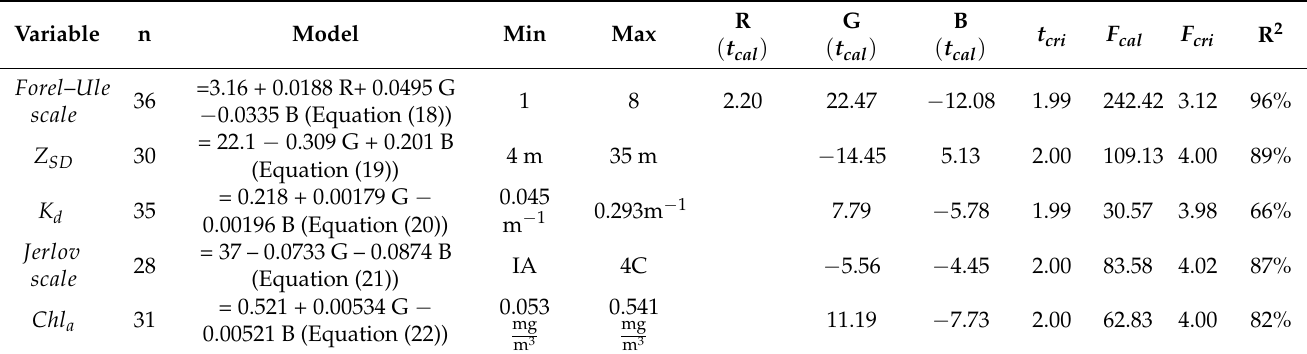
Table 3. Results of the stepwise multiple regression analysis of the models for the general approach ( α = 0.05 )